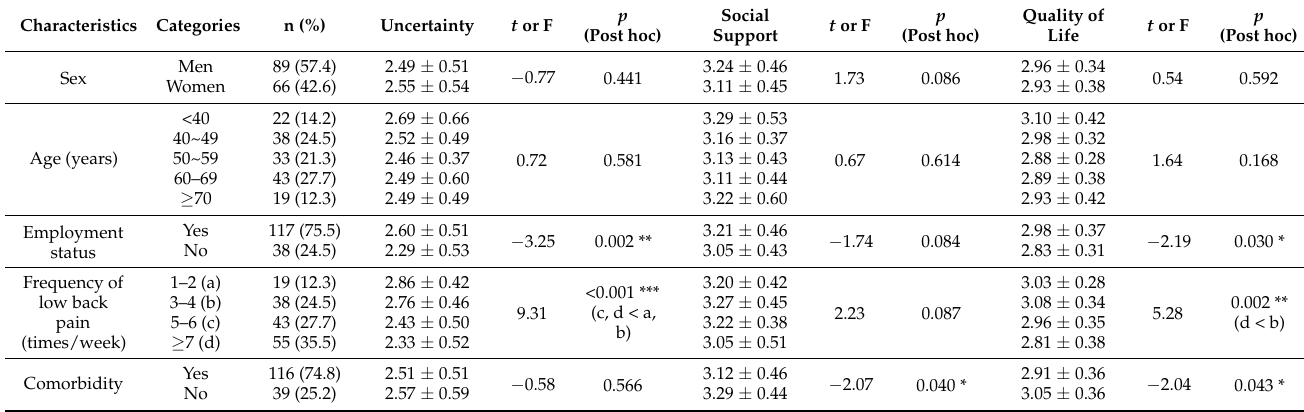
Table 1. Uncertainty, social support, and quality of life according to the general characteristics of participants (n = 155).